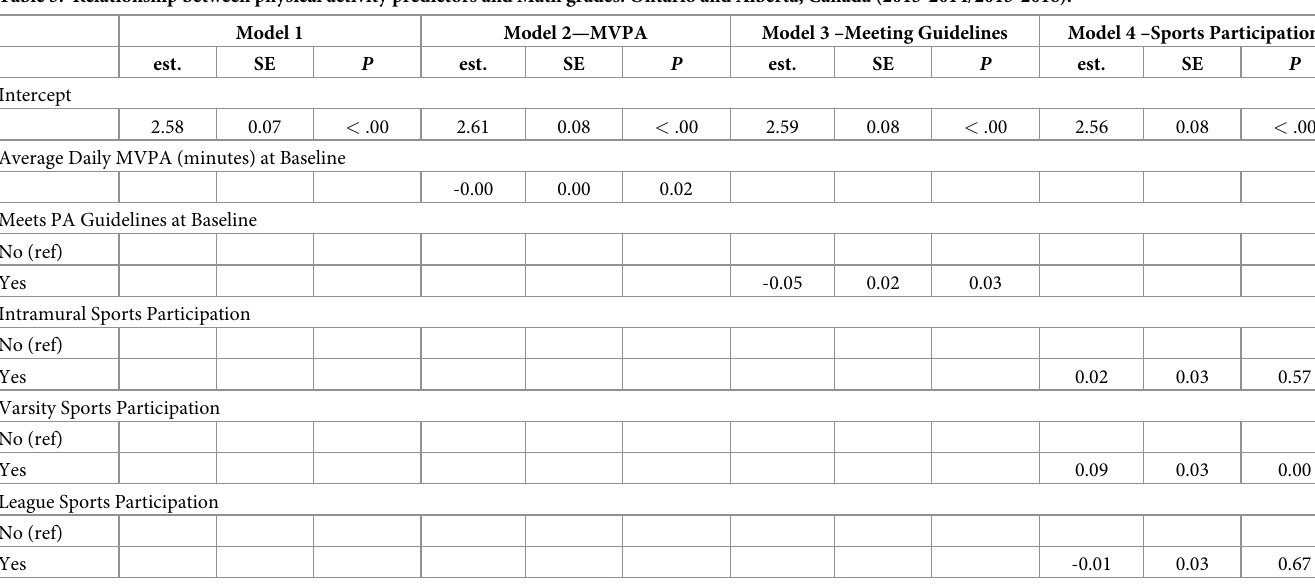
Table 3. Relationship between physical activity predictors and Math grades: Ontario and Alberta, Canada (2013-2014/2015-2016).